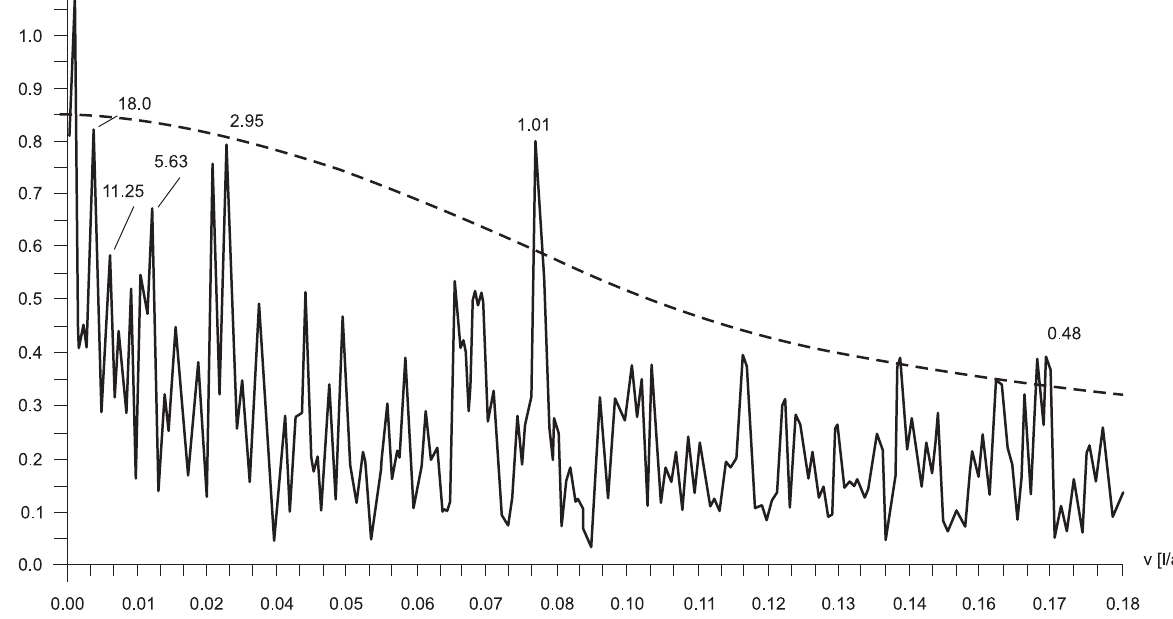
Fig. 6. Spectrum of monthly-normalised sea level values in Świnoujście. Dashed line-significance level (=0.05) for devia- tions from red